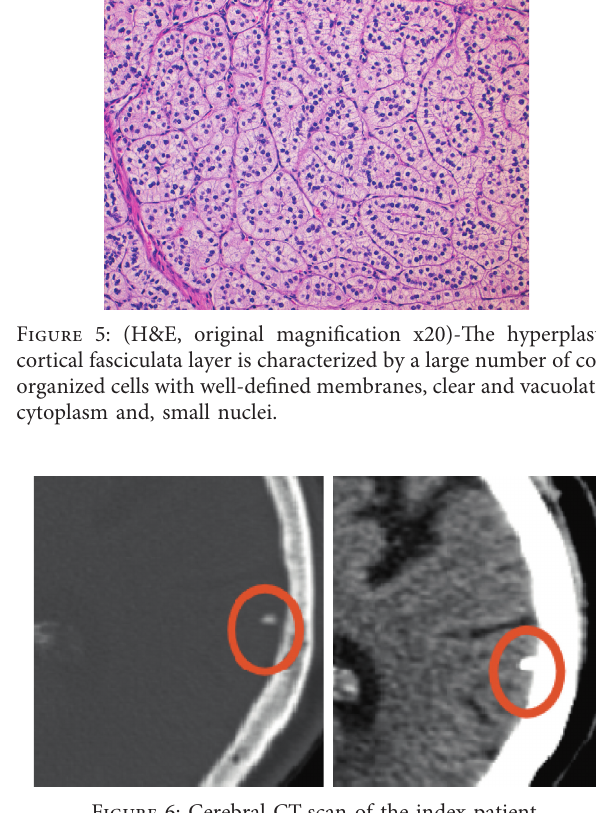
Figure 3: (H&E, original magnification x4 and x10)-There is ill- defined multinodular hyperplasia of the cortical fasciculata layer of the adrenal tissue.